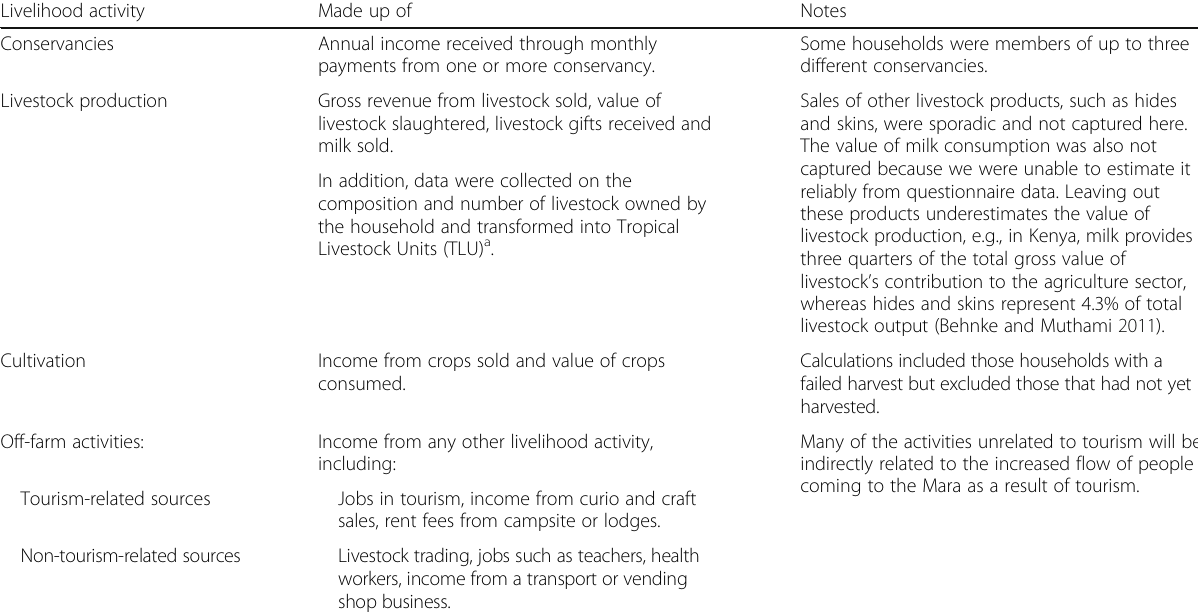
Table 1 Annual income accruing to households from the different livelihood activities Livelihood activity Made up